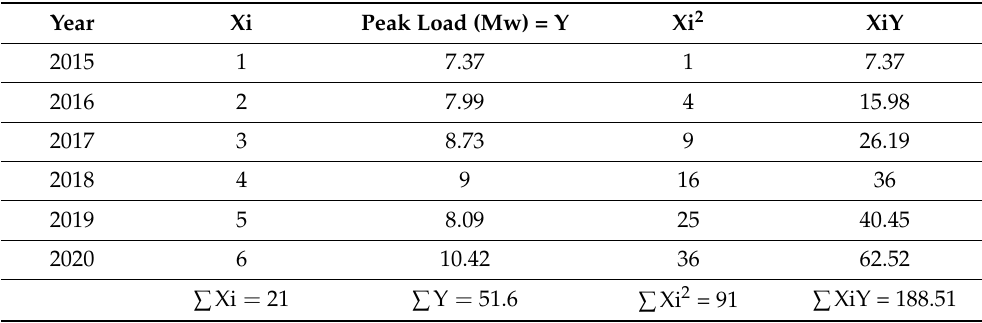
Table 1. Analysis of peak load data of Addis North-01.